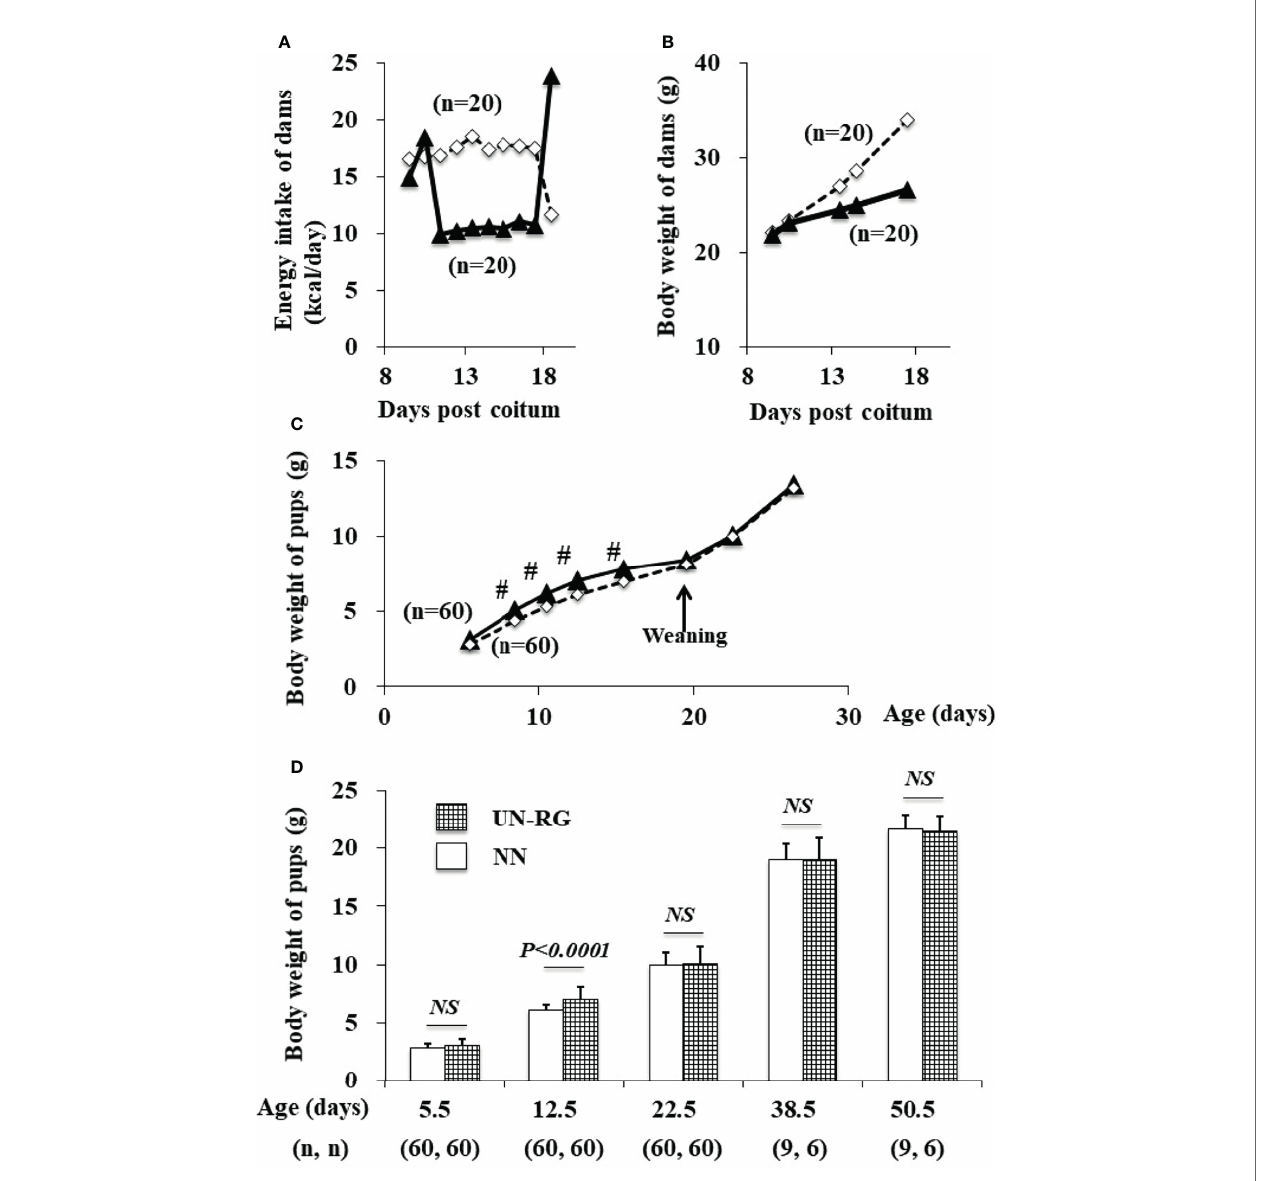
( Figure 3D ). TU did not alter energy intake per body weight (NN- TU vs NN-Veh and UN-RG-TU vs UN-RG-Veh) ( Figure 3E ). Blood lipid pro fi les and glucose levels are summarized in Table 2